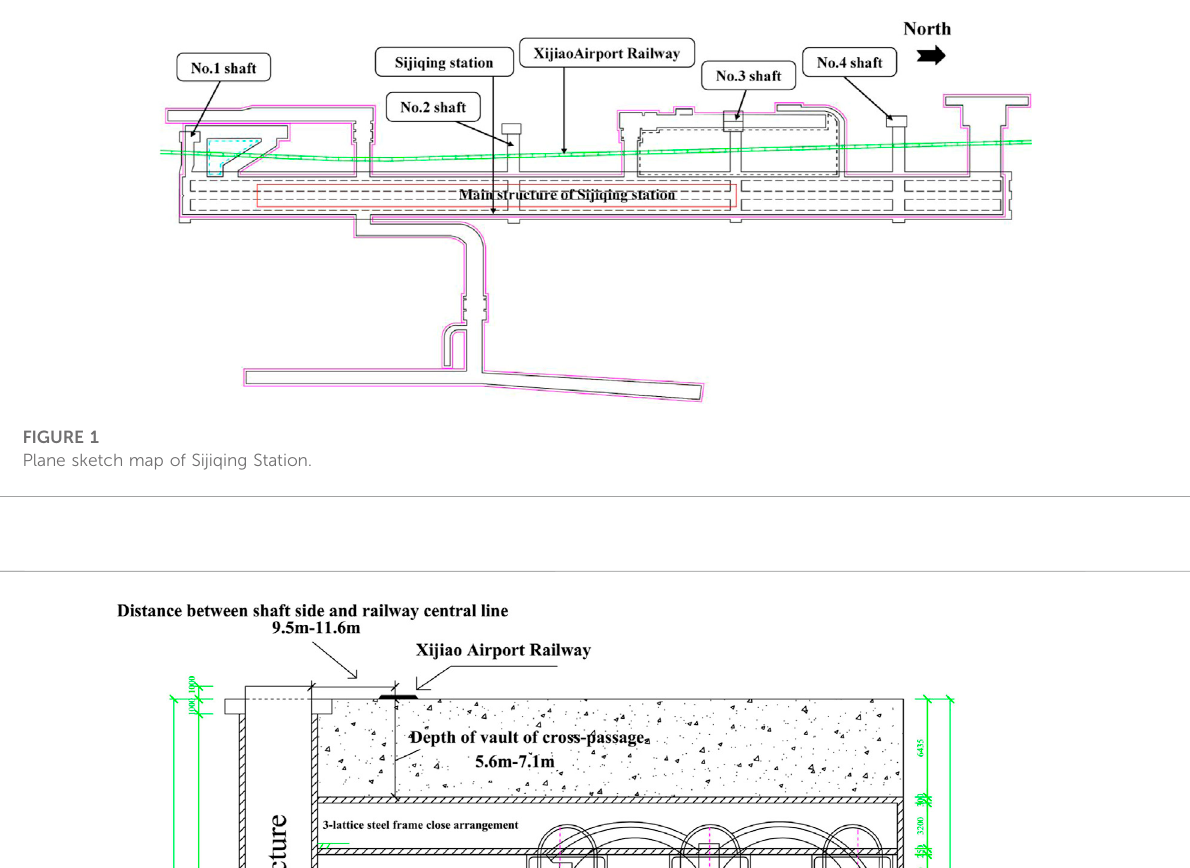
(Table 1) (China Railway Cooperation, 2014; China Railway Cooperation,